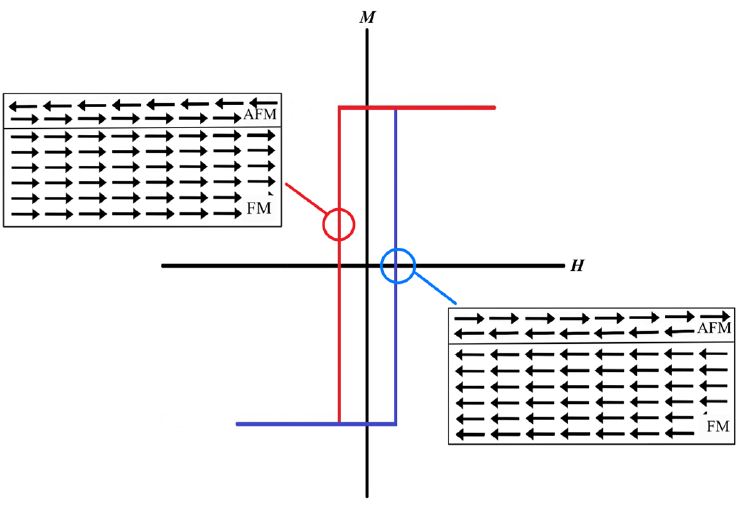
Figure 13. The magnetic moment of the Cr 2 O 3 (AFM) and Terfenol–D (FM) associated with differ- ent locations on the Terfenol–D hysteresis loop. Note that, M represents the magnetization of the FM material.